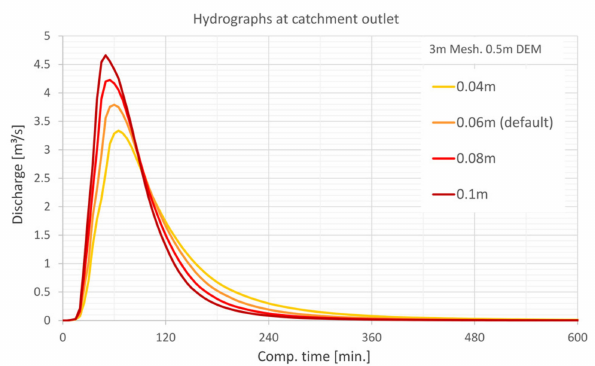
Figure 23. Qualitative comparison of the hydrographs and model sensitivity for laminar depth at the catchment outlet for 3 m mesh and 0.5 m DEM.